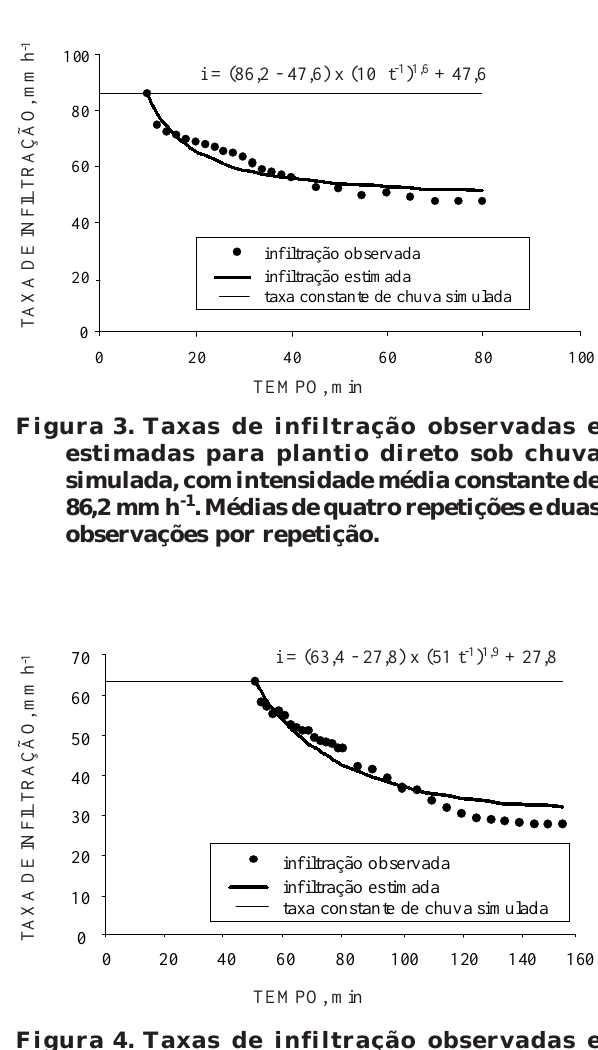
Figura 4. Taxas de infiltração observadas e estimadas para preparo convencional sob chuva simulada, com intensidade média constante de 63,4 mm h -1 . Médias de quatro repetições e duas observações por repetição.